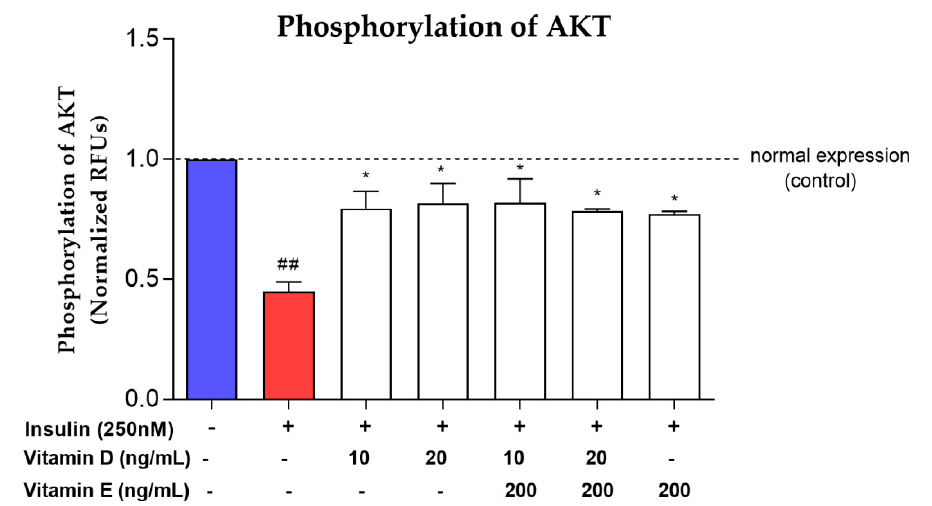
Figure 6. AKT phosphorylation level in insulin-resistant cells upon treatment with various concentrations of vitamins D and E. Red bar represents AKT phosphorylation level upon induction with 250 nM insulin for 16 h. White bar represents AKT phosphorylation level upon treated with vitamins D and E for 24 h after induced with 250 nM insulin. Relative p- AKT phosphorylation levels were normalized to total AKT and were expressed as fold increase over control. Data were expressed as mean ± SEM of three independent experiments. Significant values were expressed as * p < 0.05 compared to the negative control group and ## p < 0.01 compared to the control group.